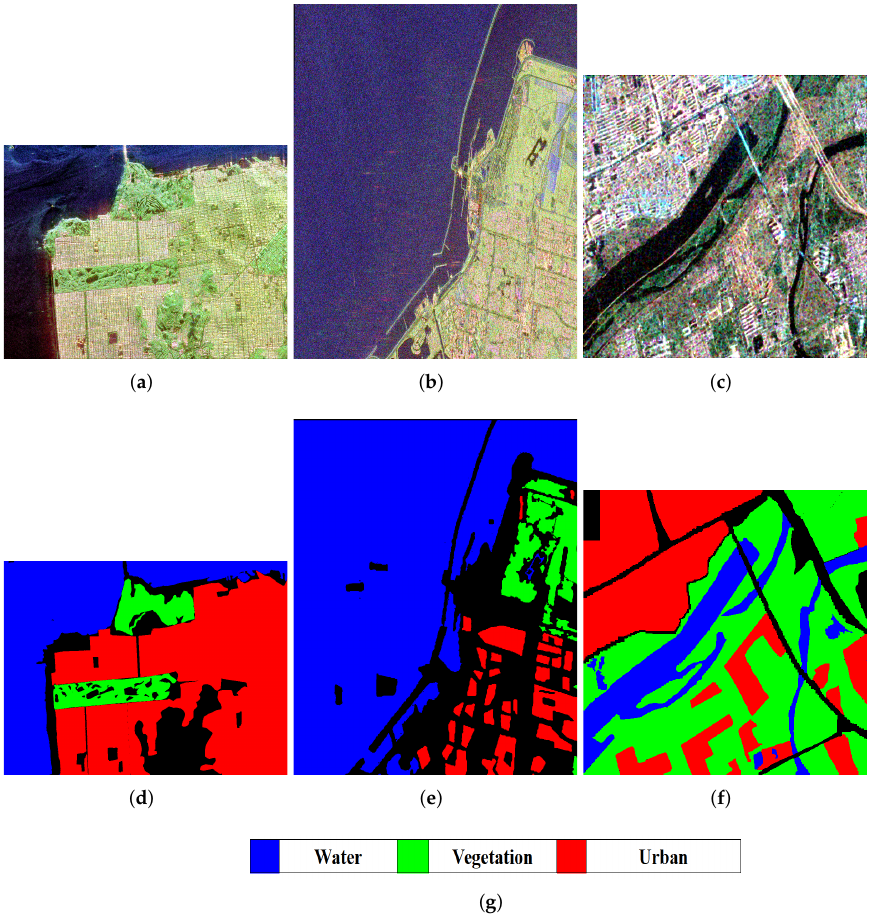
Figure 7. PauliRGB images and ground truths for three PolSAR images and their color code.